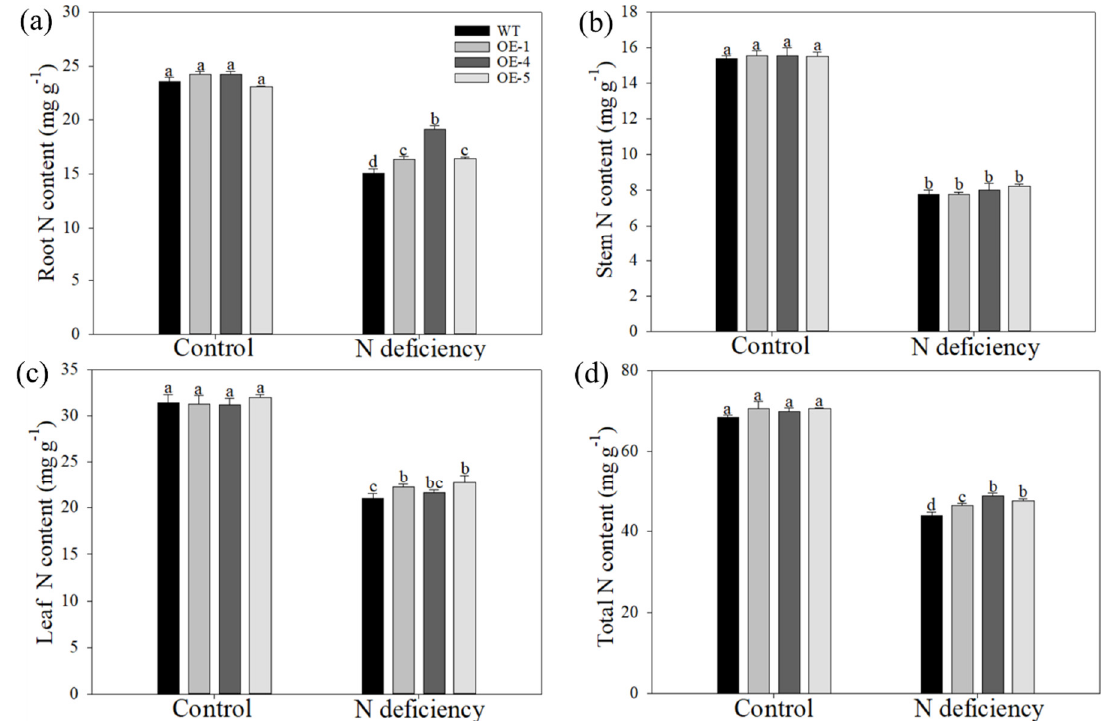
Figure 5. Overexpression of MdATG10 leads to higher nitrogen concentration in apple under nitrogen deficiency stress. Changes of nitrogen concentrations in the ( a ) roots, ( b ) stems, ( c ) leaves, and ( d ) total of WT and transgenic apple plants. Data are shown as the means of three replicates with SEs. Different letters indicate significant differences between treatments, according to one-way ANOVA followed by Tukey’s multiple range test ( p < 0.05).